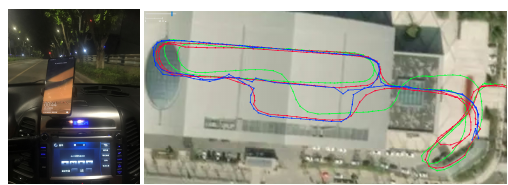
Figure 13. Smartphone mounting and the trajectory in underground parking garage (Blue: BLE; Green: INS/NHC;